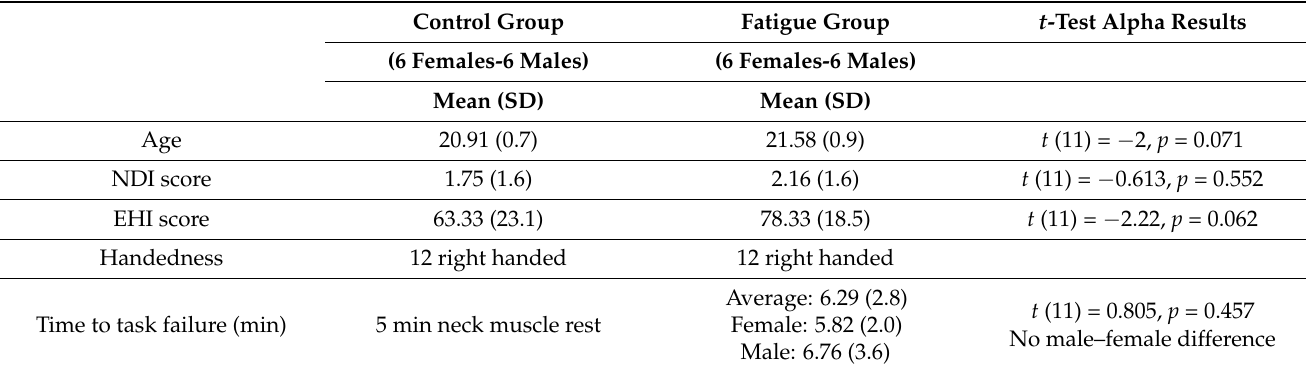
Table 1. Participant demographics and self-report